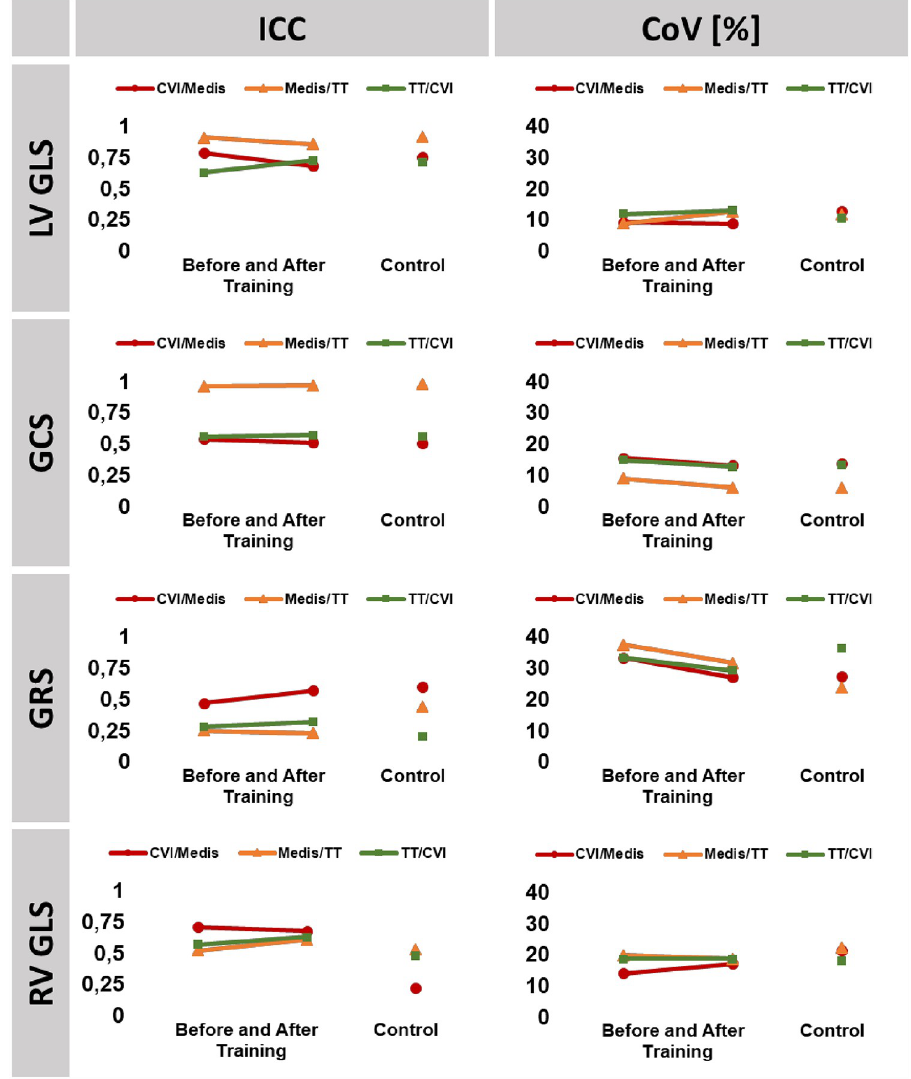
Fig 4. Inter-vendor reproducibility. The graph shows interclass correlation coefficients (ICC) and coefficients of variation (CoV) for inter-vendor agreement prior to and after training as well as the agreement of a trained investigator (control) as a reference. LV/RV: left/right ventricle, GLS: global longitudinal strain, GCS: global circumferential strain, GRS: global radial strain.